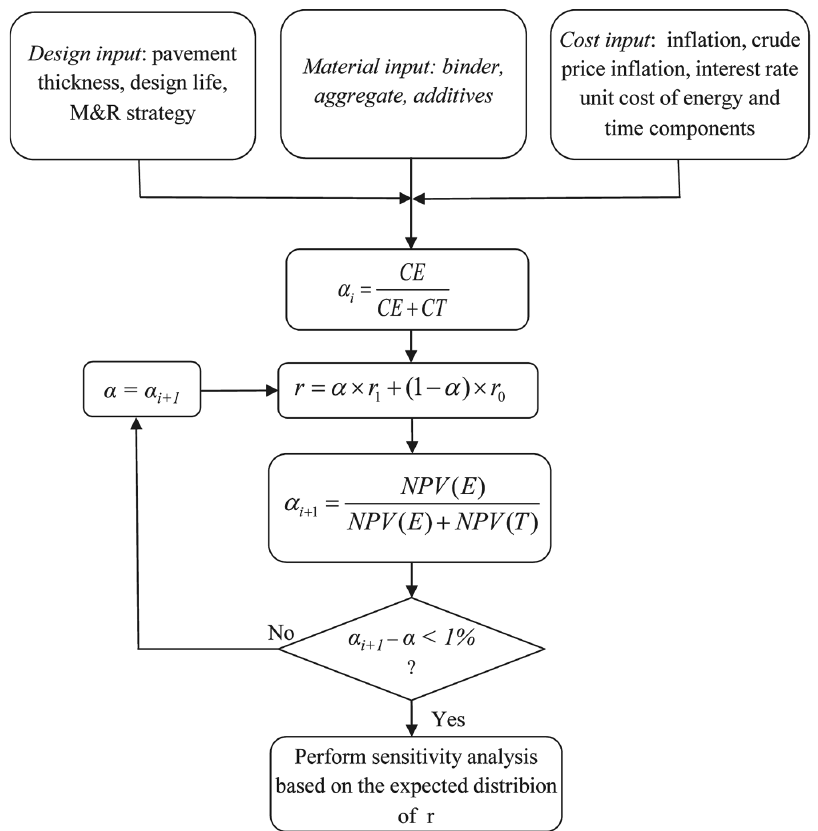
Fig. 2. The flowchart to calculate the equivalent discount